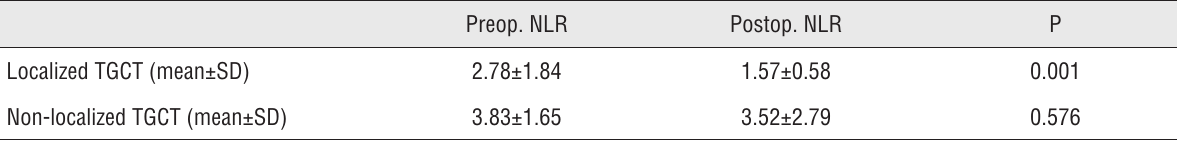
Table 2 - Preoperative and postoperative neutrophil to lymphocyte ratio in localized and non-localized TGCT. Preop. NLR Postop. NLR